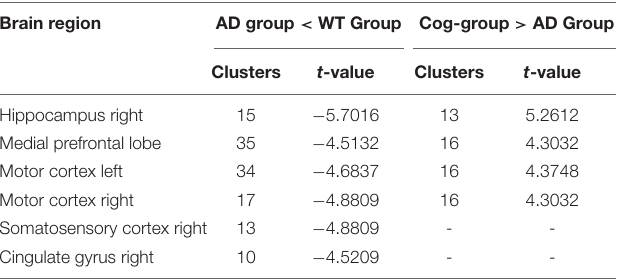
TABLE 1 | Regions showing significant changes in functional activity.